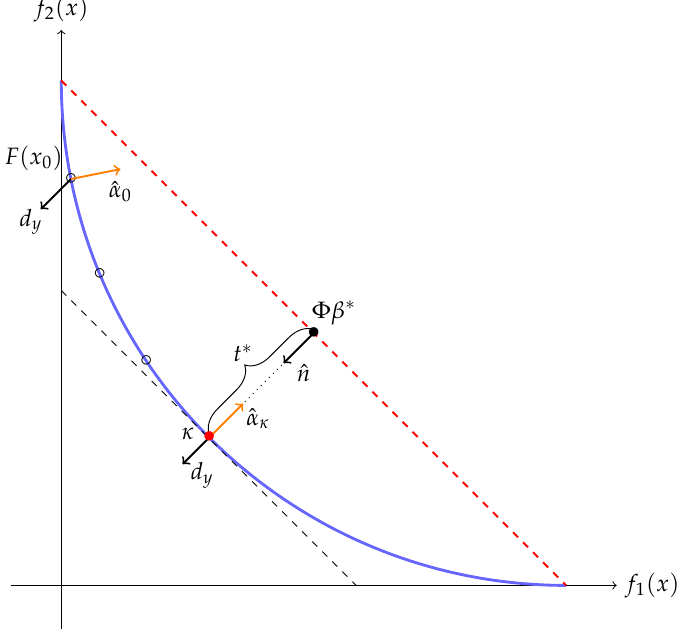
Figure 5. Illustrative example of the use of Pareto Explorer (PE) to find the knee. Here, we start the steering in objective space at the point x 0 (which has ˆ α 0 ) in the direction d y : = ˆ n . We compute a sequence of points until the stop criterion (a) is satisfied, i.e., the knee κ = ( f 1 ( x ∗ ) , f 2 ( x ∗ )) T . Notice that ˆ α κ (associated to x ∗ ) is in the opposite direction of ˆ n